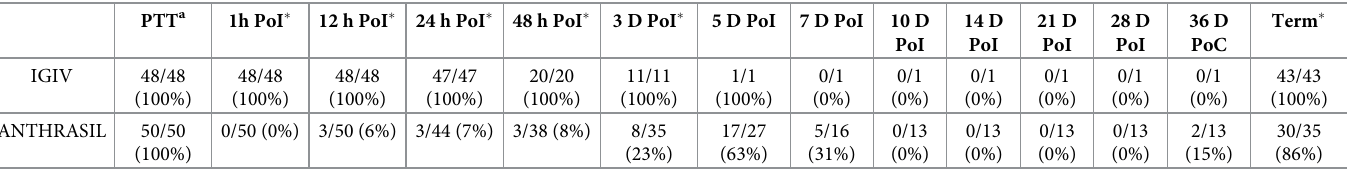
Table 3. Proportion of B . anthracis -infected rabbits toxemic post-treatment with IGIV or ANTHRASIL. PTT a